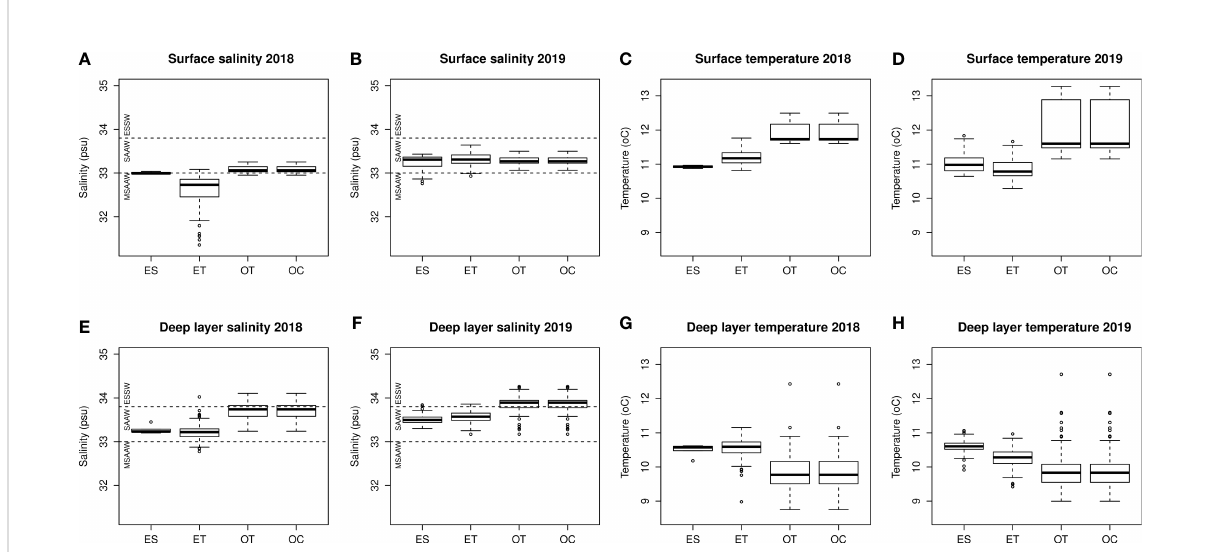
FIGURE 3 Boxplots of surface salinity (A, B) , surface temperature (C, D) , deep layer salinity (E, F) , and deep layer temperature (G, H) for April 2018 and April 2019, and per oceanographic zone. ES, Estuarine zone; ET, Estuarine Transition zone; OT, Oceanic Transition zone; OC, Oceanic zone. Dashed lines show salinity-based water mass de fi nitions according to (Pe ́ rez-Santos et al., 2014) for this area. ESSW, Equatorial Subsurface Water; SAAW, Subantarctic Water; MSAAW, Modi fi ed Subantarctic